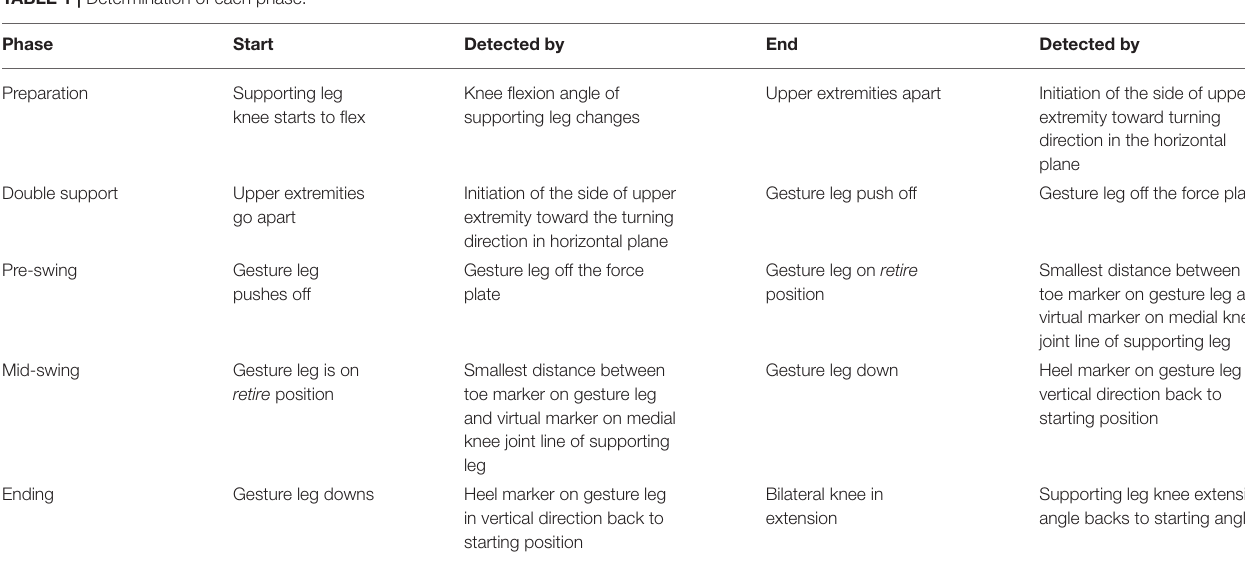
TABLE 1 | Determination of each